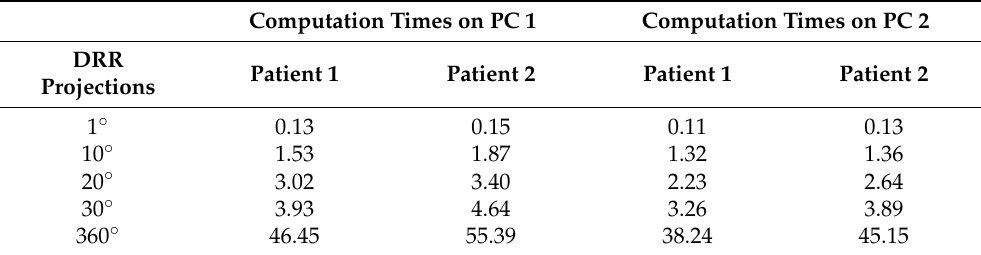
Table 4. Summary of computation times in minutes of image registration per range of rotation angles of DRR projections across all patient datasets.